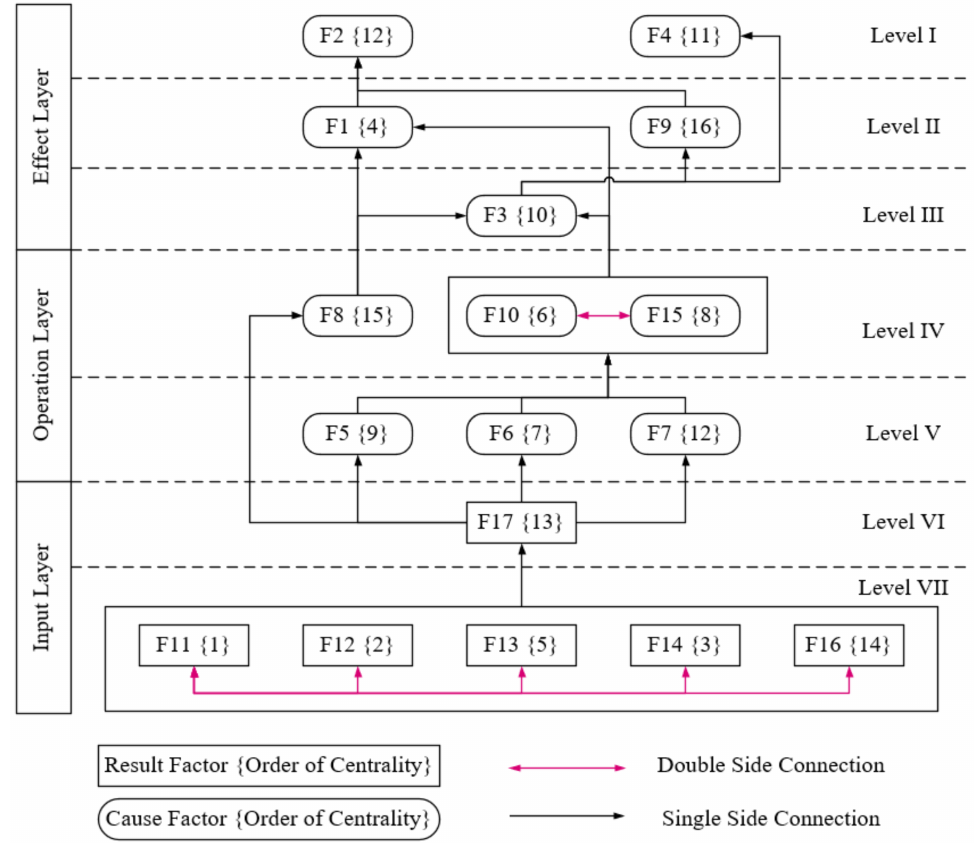
Figure 4. DEMATEL-ISM model of smart construction site